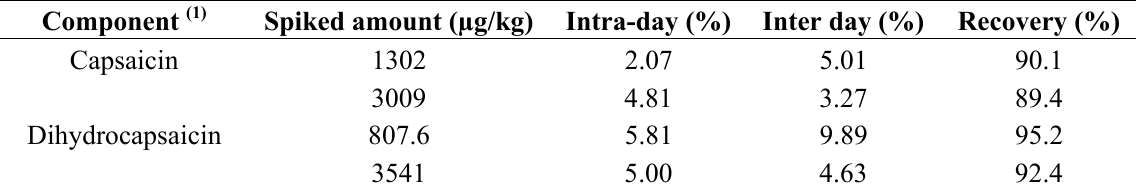
Table 4. Precision and accuracy data of the UFLC for the determination of capsaicinoids in AVPP0705.